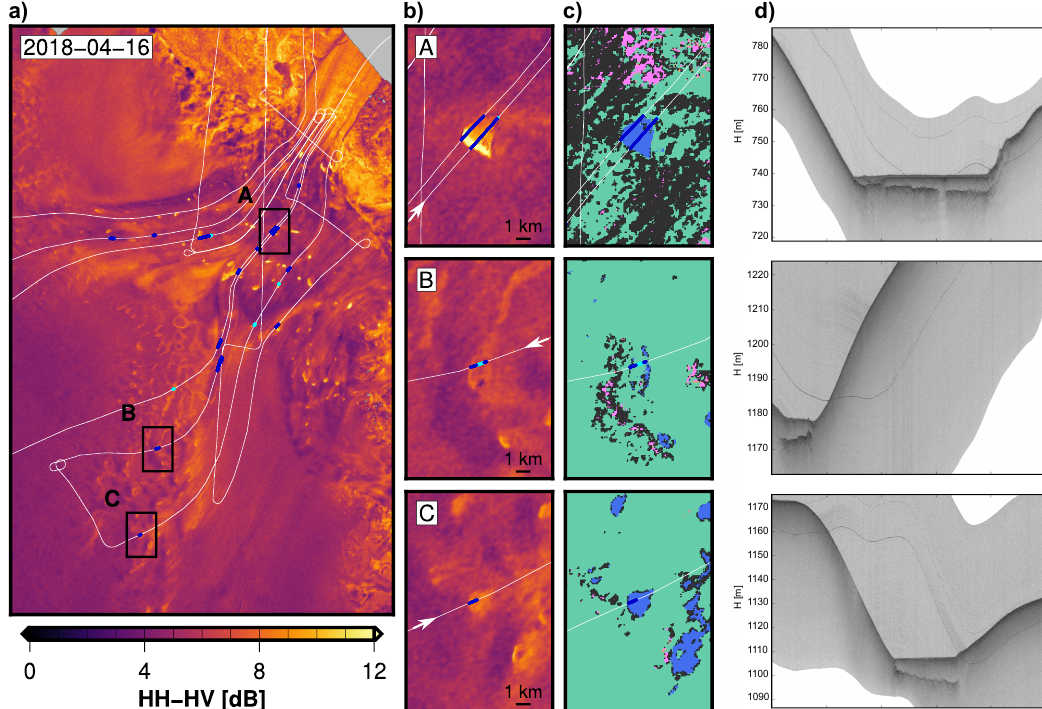
Figure 6. ( a ) Comparison between SGLs from PBC and airborne snow radar picks. Dark blue dots denote an agreement in classification between both techniques; UWBM-picks without a corresponding classification by PBC on 16 April 2018 are shown in cyan. Three detailed examples on the right show HH–HV ( b ), the classification result (( c ), colors as in Figure 3) and the corresponding radar profiles ( d ). The white arrows in ( b ) denote the flight direction, i.e., the orientation of the radar profiles from left to